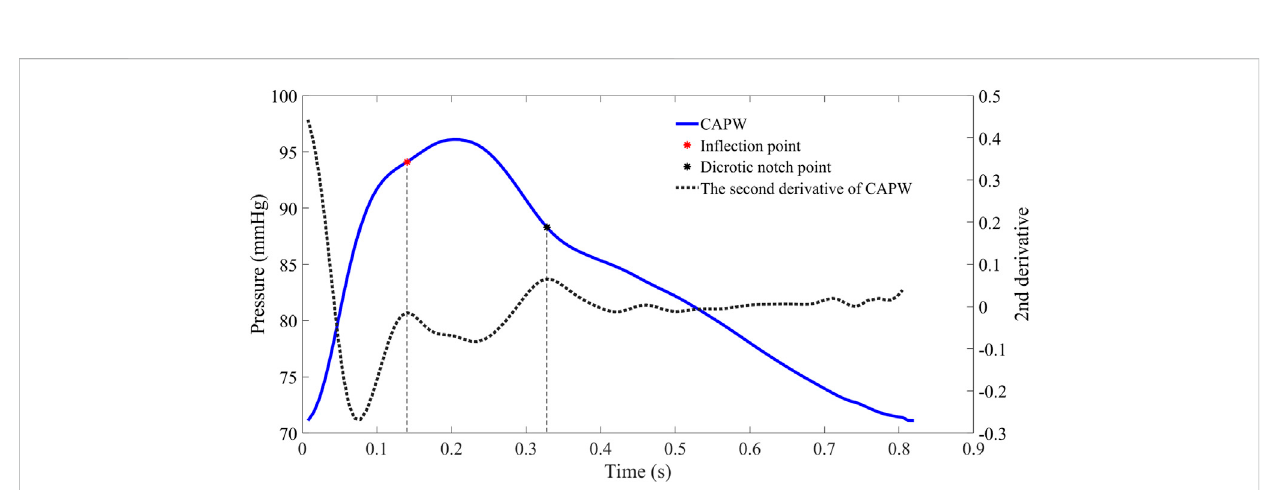
FIGURE 2 The CAPW feature points extraction. The red point represents the in fl ection point of the pulse wave (the moment when the P b is generated), while the black point represents the dicrotic notch point (the end of the systolic phase or the beginning of the diastolic